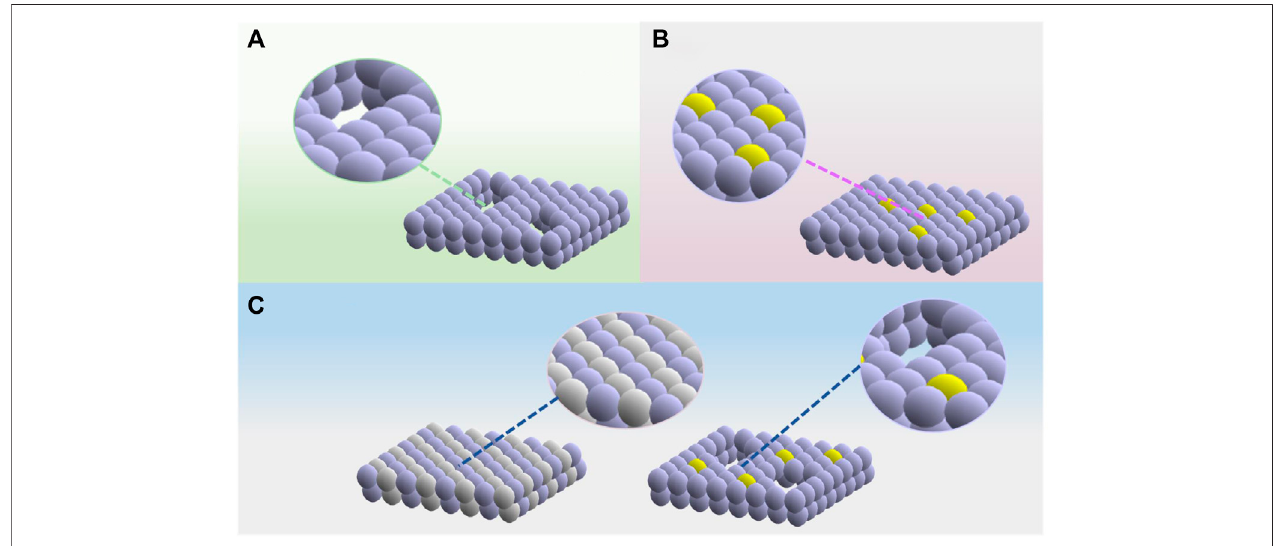
FIGURE 1 | Sur fi cial modulations on 2D semiconductor photocatalysts discussed in this mini-review. (A) Surface vacancies. (B) Single-atom modi fi cation. (C) Dual-site components.